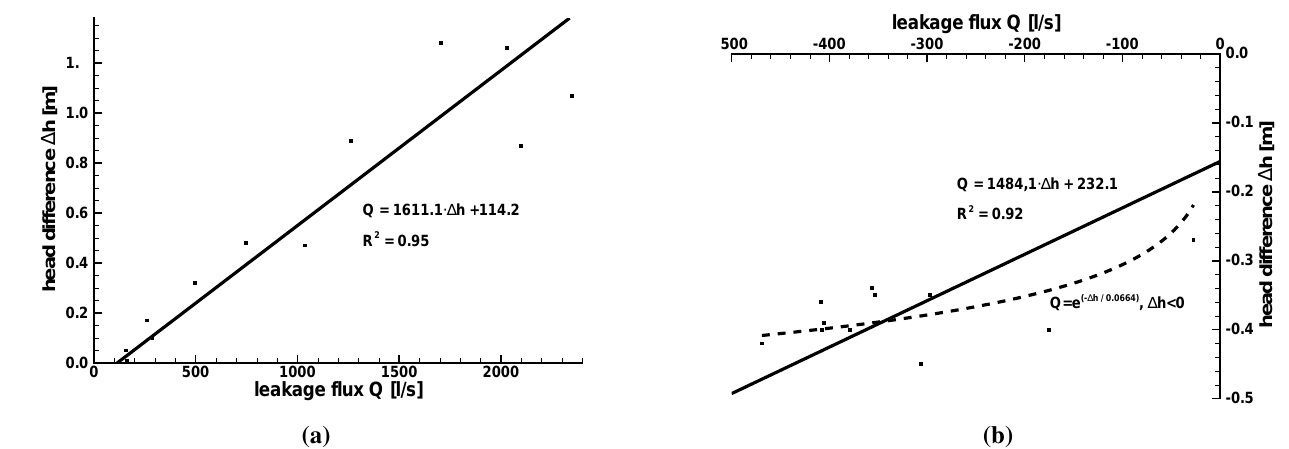
Figure 7. Head difference ∆ h over leakage flux Q for observation point U01 (data taken from [12]) and the smoothing function. ( a ) Infiltration towards the aquifer; ( b ) exfiltration towards the River